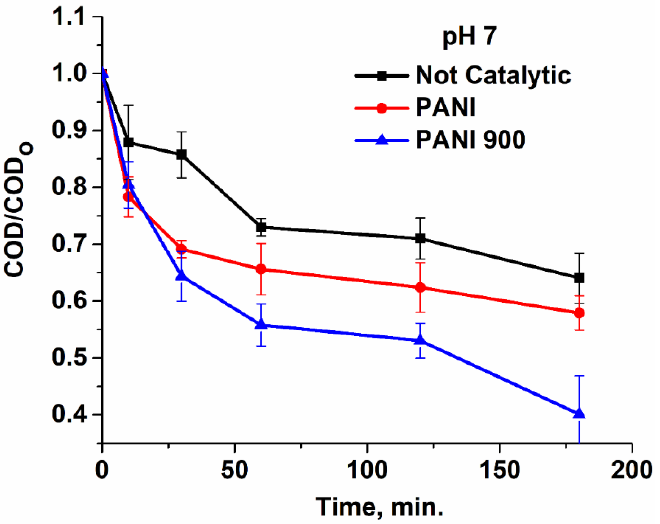
Figure 15. Evolution of normalized COD with reaction time in the presence and absence of